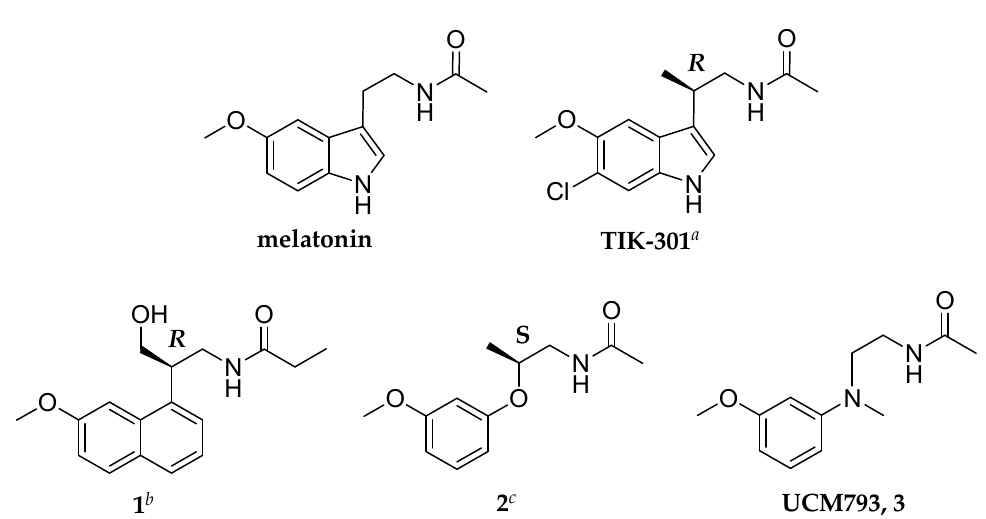
Figure 1. Melatonin, N -{2-[(3-methoxyphenyl)methylamino]ethyl}acetamide (UCM793), and melatoninergic compounds bearing modifications on the ethylamide side chain: TIK-301, ( R )- N -[3-hydroxy-2-(7-methoxynaphthalen-1-yl)propyl]propanamide ( 1 ) and ( S )- N -[2-(3-methoxyphenoxy) propyl]acetamide (2). a K i (MT 1 ) = 0.081 nM; K i (MT 2 ) = 0.042 nM [7]. b p K i (MT 1 ) = 8.47; p K i (MT 2 ) = 9.50 [9]. c p K i (MT 1 ) =